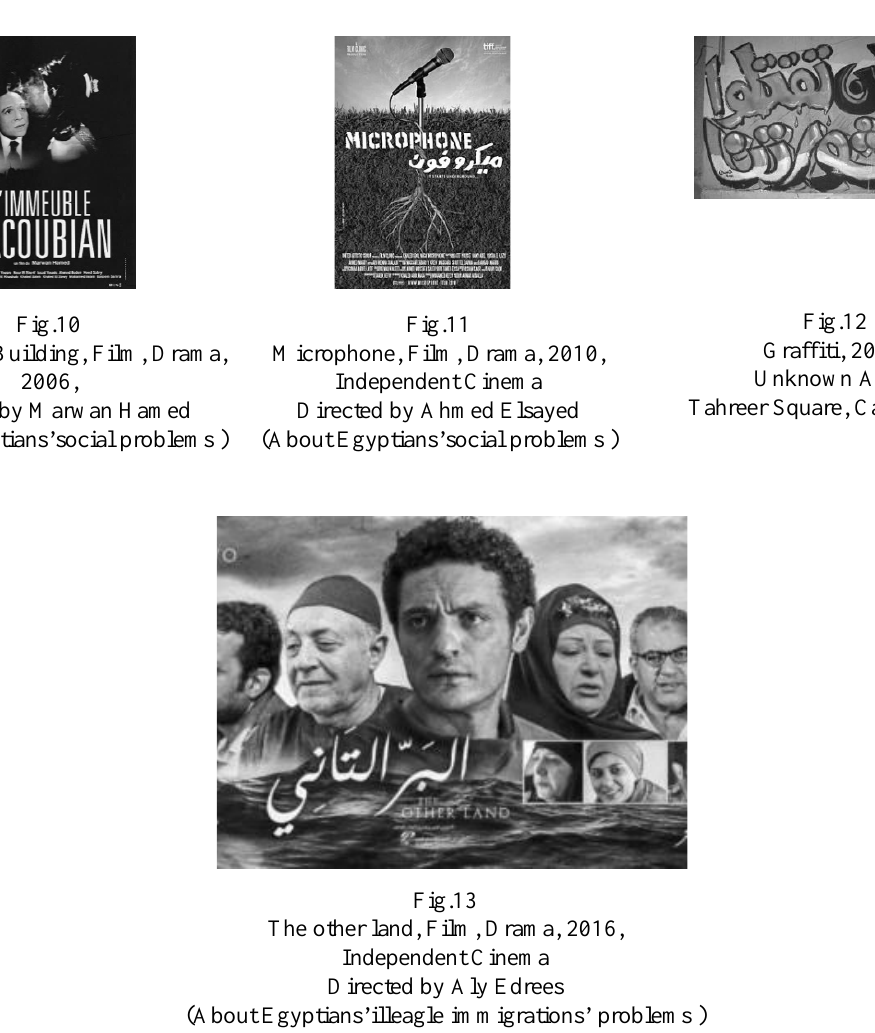
The other land, Film, Drama,